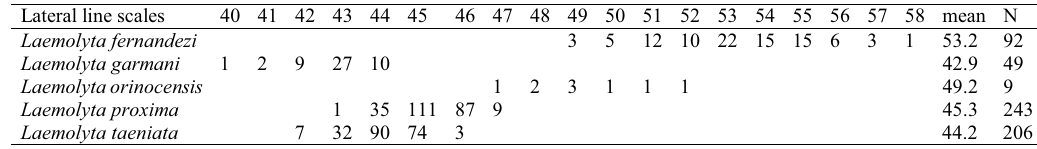
Table 2. Frequency distribution of lateral line scales in Laemolyta. Lateral line scales